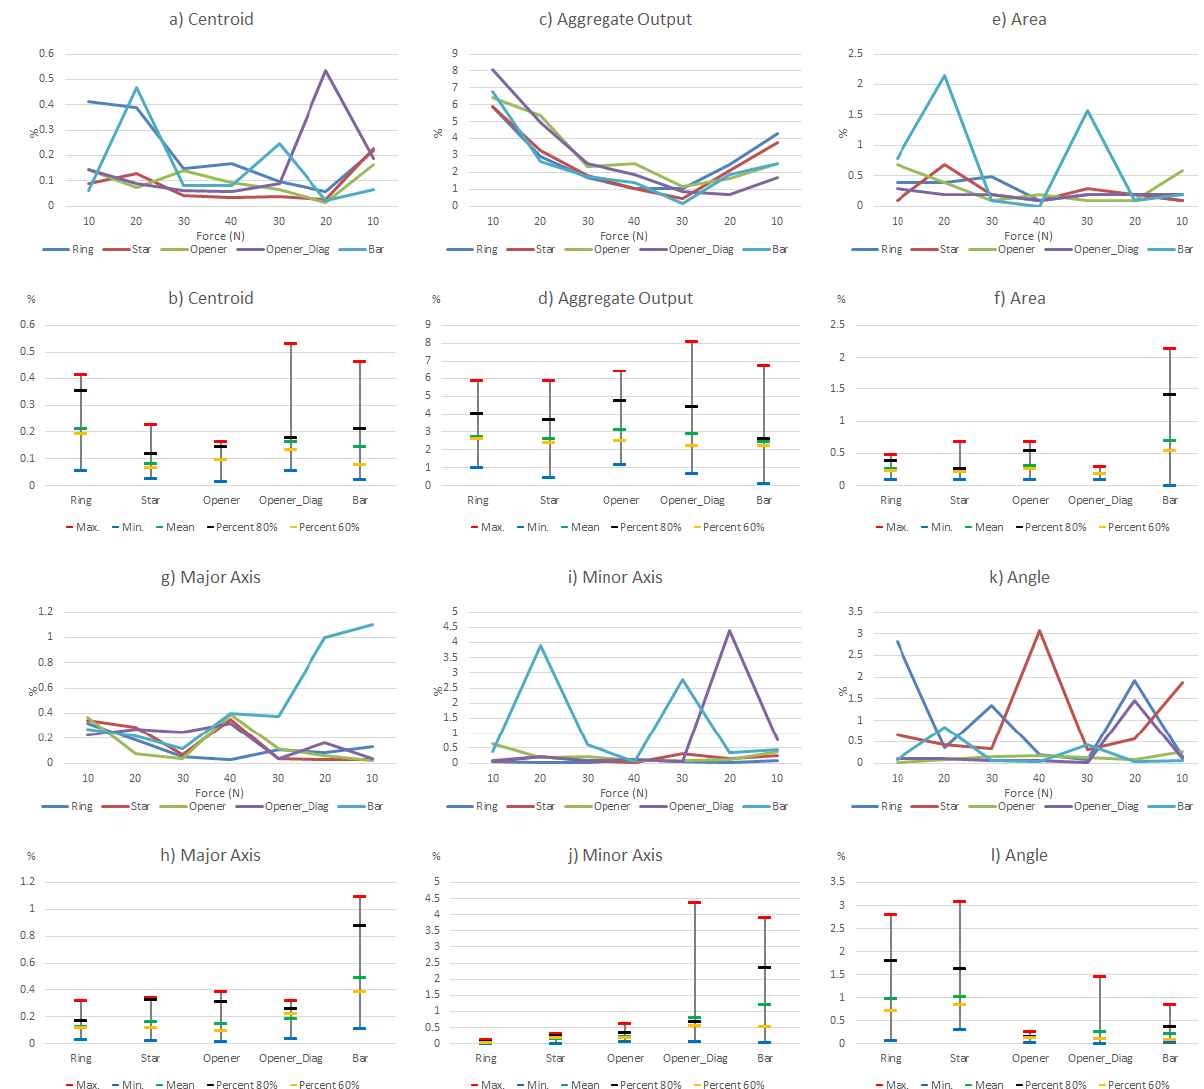
Figure 10. Variations of the system level parameters caused by the commercial sensor drift.